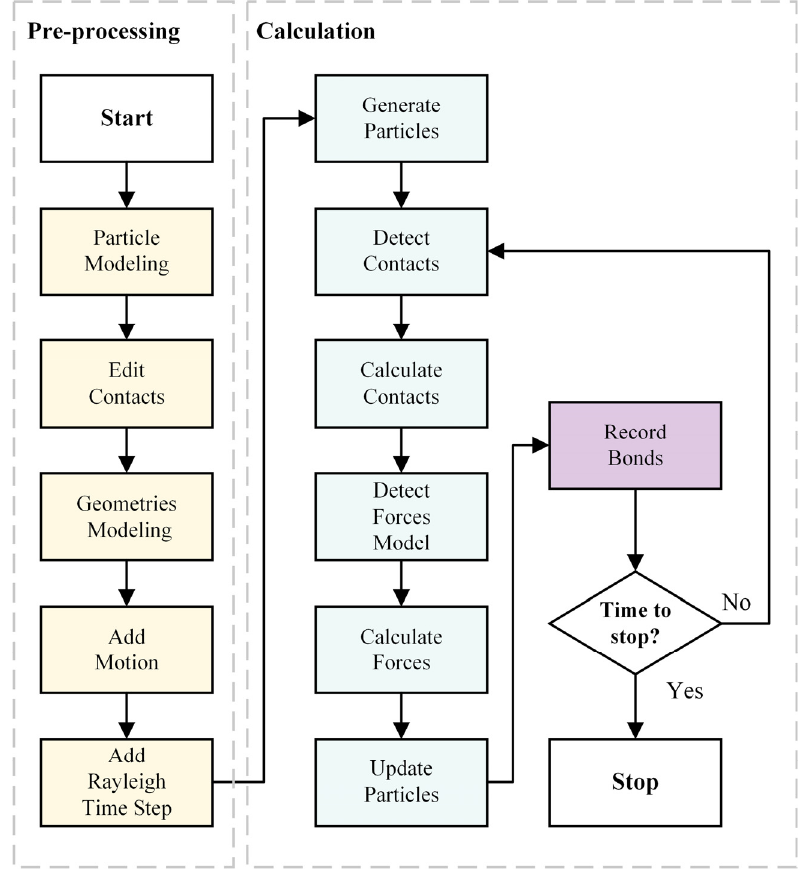
Figure 2. DEM Simulation.